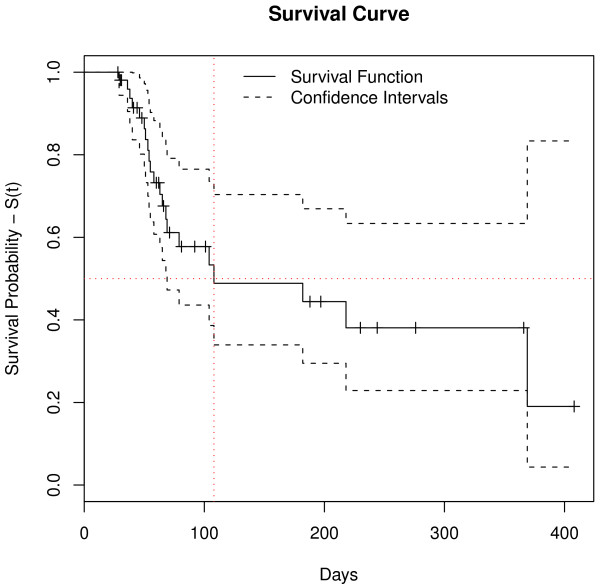
Survival curve. Overall Kaplan-Meier survival curve for P. vivax malaria relapse among patients included in the study (IPEC, 2005-2011). Survival function is defined as the probability of relapse not occurring.